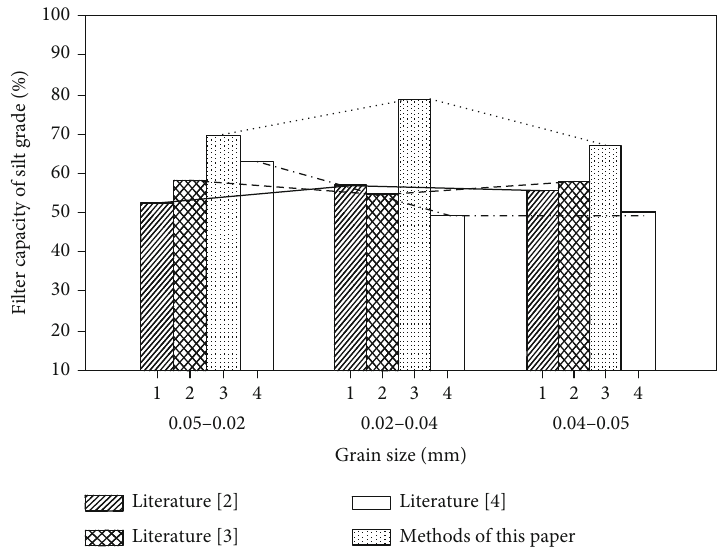
Figure 4: Experimental results on silt-grade sieve fi lter performance.